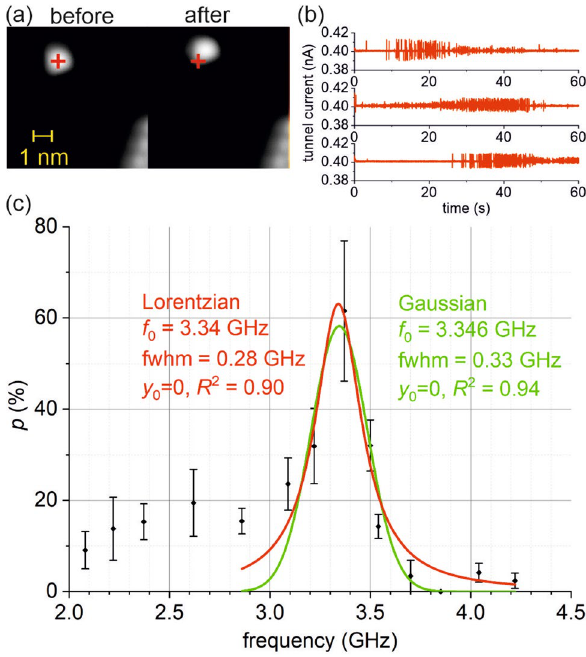
Figure 2. ( a ) STM images of a single BA7H molecule before and after RF pulsing ( 7.5 × 7.5 nm; z scale 350 pm; tunnel conditions: + 0.5 V 9 pA). The cross marks the initial position of the molecule. ( b ) Typical tunnel current traces during RF pulse for the case that SMJ displacement occurs. ( c ) Frequency dependence of the probability p of lateral displacement of the SMJ (see text) for constant RF amplitude of V RF = 100